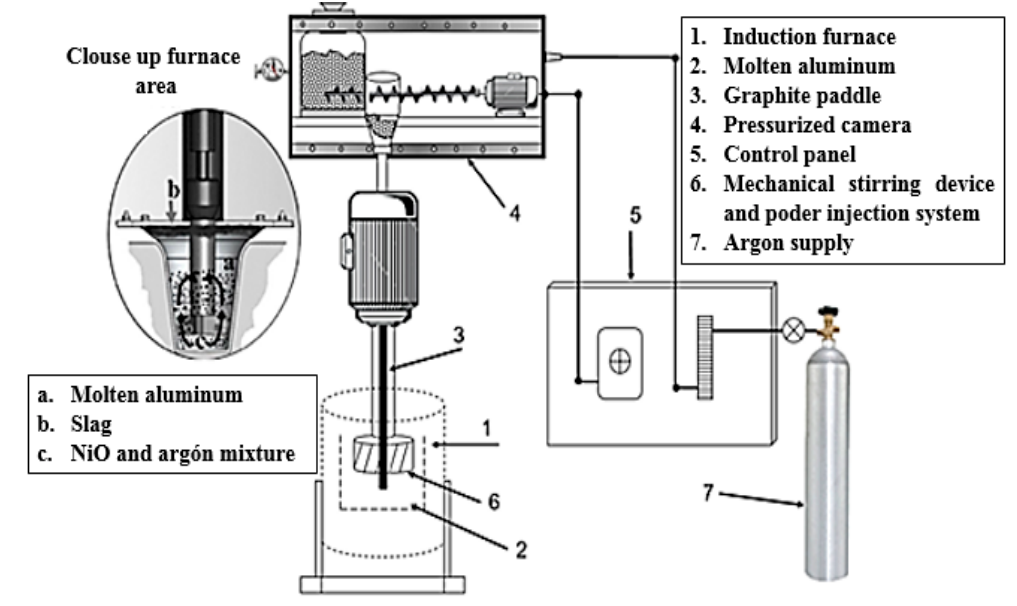
Figure 1. Schematic illustration of the experimental set-up employed in the experiments of the submerged powder injection with mechanical agitation.